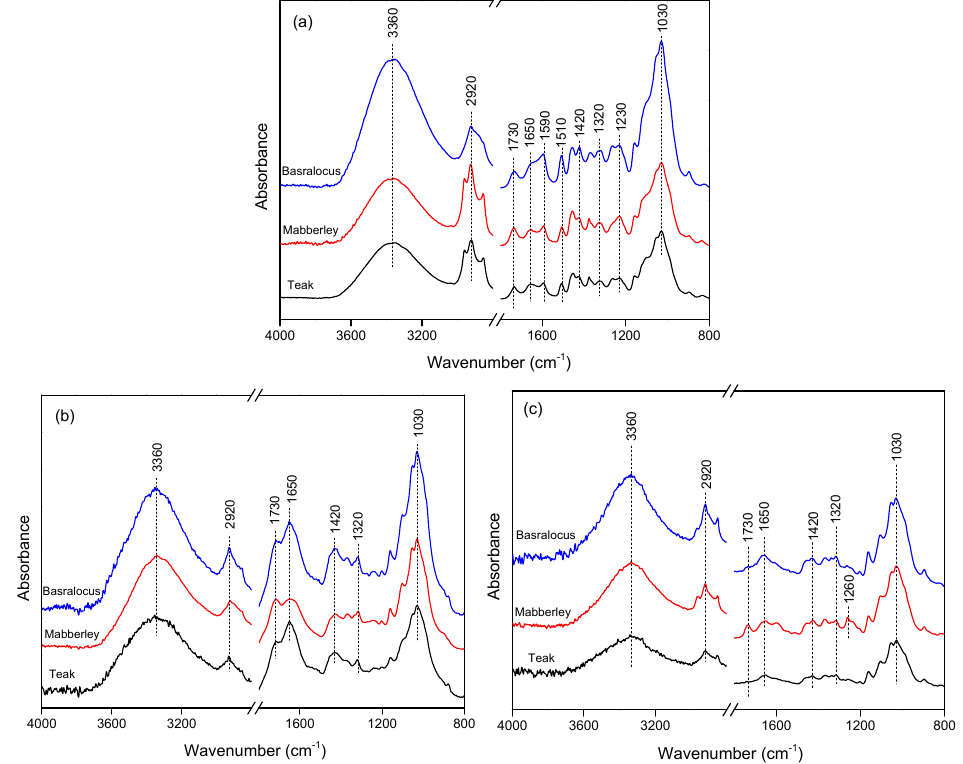
Figure 6. ATR-FTIR spectra of woods before and after aging. ( a ) Before aging; ( b ) after 733 days of natural sunlight aging; ( c ) after 60 h of artificial xenon light aging.